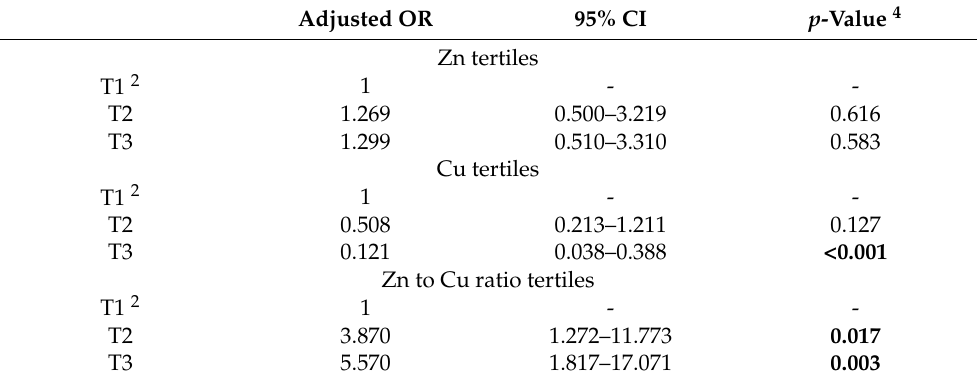
Table 5. Association between serum Zn, Cu, and Zn/Cu and the risk of having MetS 1,3 . Adjusted OR 95% CI p -Value 4 Zn tertiles